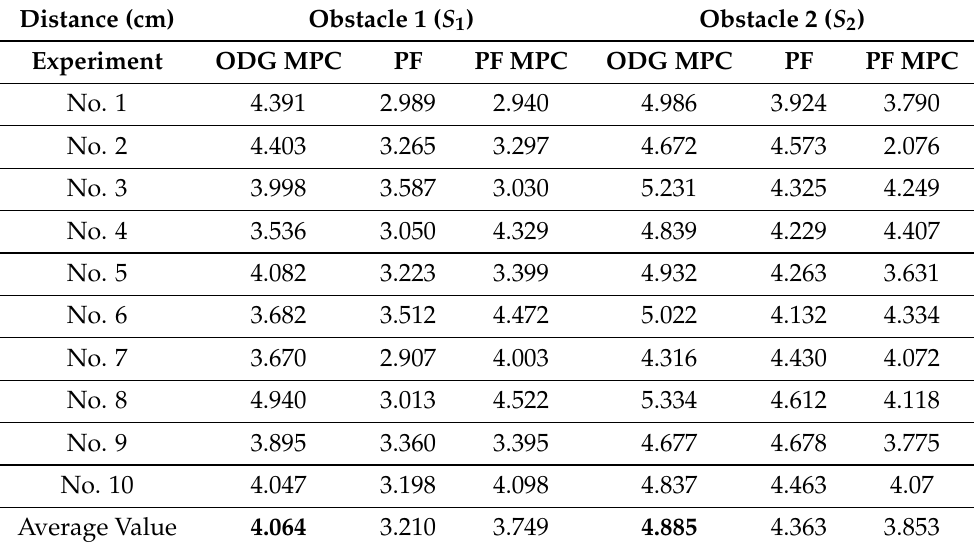
Figure 28. Results of the obstacle distance from Scenario 3 for static Obstacle 2. Table 11. Results of the minimum distance from Scenario 3 for two static